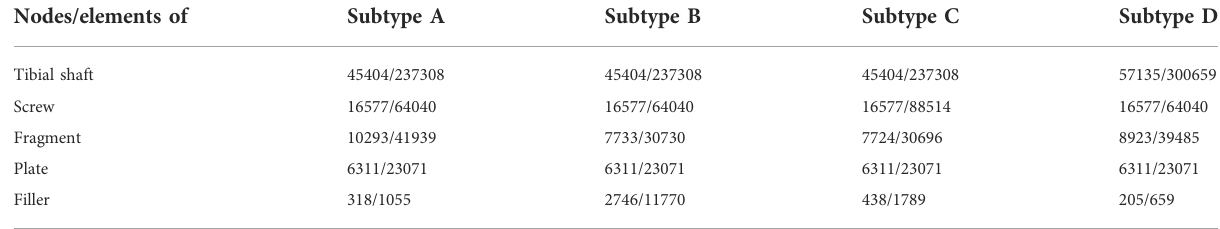
TABLE 1 Parameters of the FE